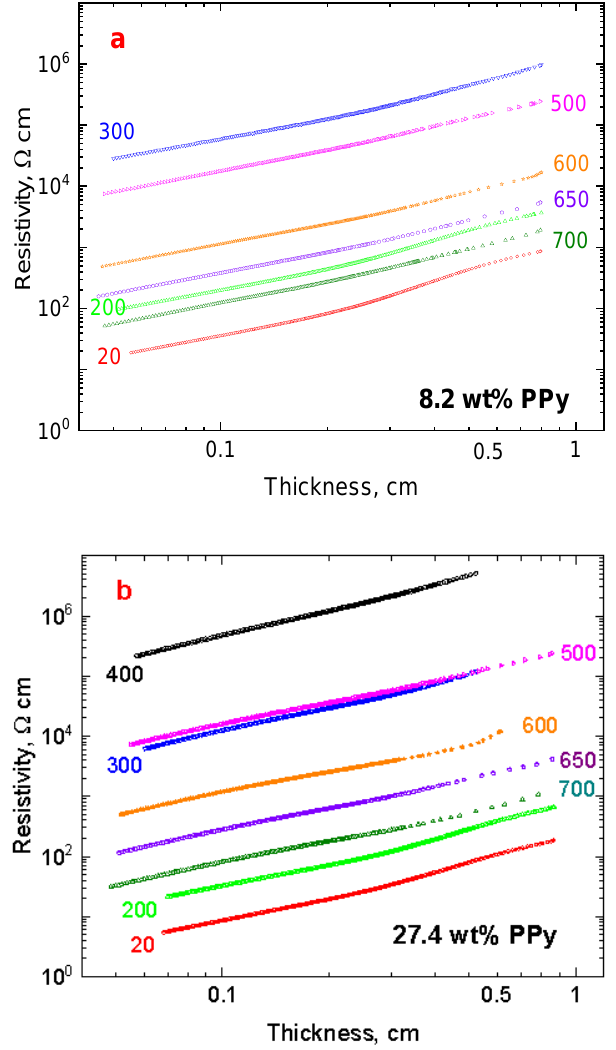
Figure 11. Resistivity of polypyrrole-coated sponges exposed to various temperatures 20–700 °C on the sample thickness during compression at 0.04–1 MPa pressure. Polypyrrole content ( a ) 8.2 wt%, and ( b ) 27.4 wt%.